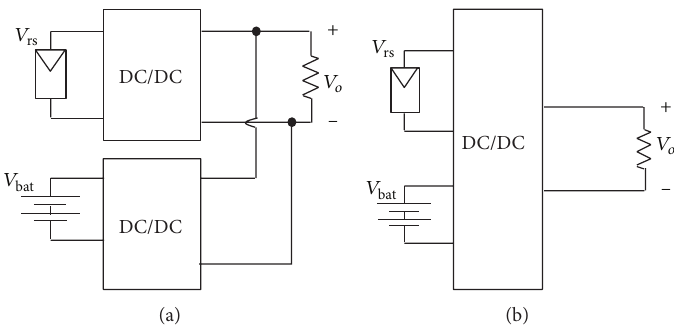
Figure 1: Standalone systems: (a) multistage, (b) integrated stage.